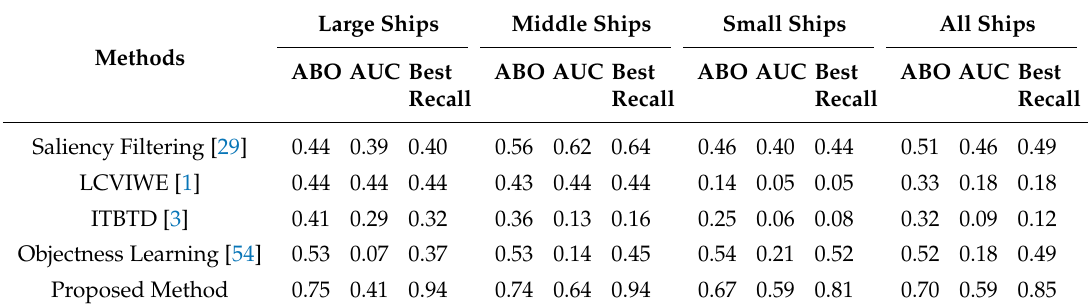
Figure 11. The recall using our method and the state-of-the-art methods. ( a ) the curves measuring the recall versus numbers of ship proposals; ( b ) the curves measuring the recall versus IoU. Table 3. Comparison of ABO scores, AUC and best recall for the proposed method and the state-of-the-art methods on test datasets that contain multi-scale